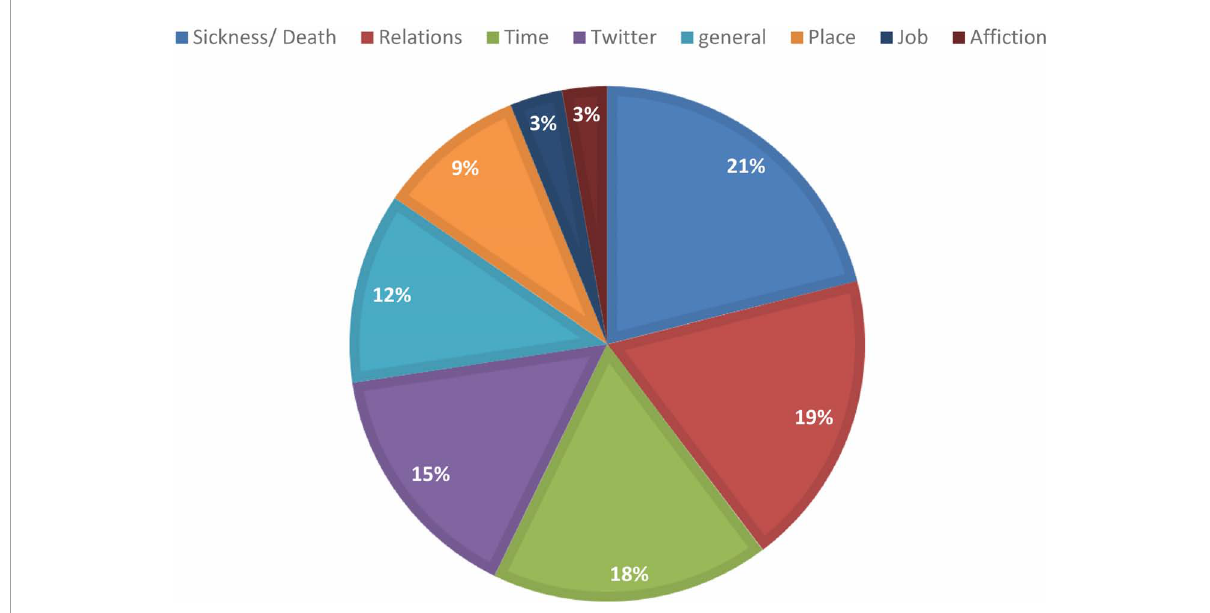
FIGURE3 Major semantic categories in the